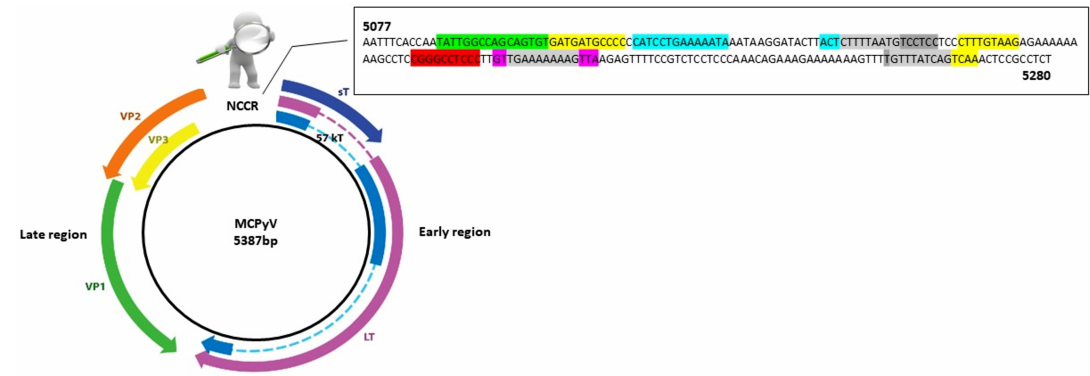
Figure 1. Schematic representation of the MCPyV genome (strain MCC350). The double-stranded DNA genome is 5387 bp in length. The early region encodes the large T antigen (LT), small T antigen (sT), 57 kT antigen (57 kT) and ALTO (alternate frame of the large T open reading frame). These genes function to allow for viral DNA replication. The late region is transcribed in the opposite direction and encodes the structural components of the virus capsid: virus protein 1 (VP1) and the minor capsid proteins virus protein 2 (VP2). MCPyV does not seem to express virus protein 3 (VP3), and virions do not seem to contain VP3, despite an in-frame internal ATG start codon in the VP2 gene. At the top of the figure, the amplified noncoding control region (NCCR) of 203 base pair (bp) (5077 – 5280 bp). Putative binding sites for cellular transcription factors are highlighted in different colors as follows: